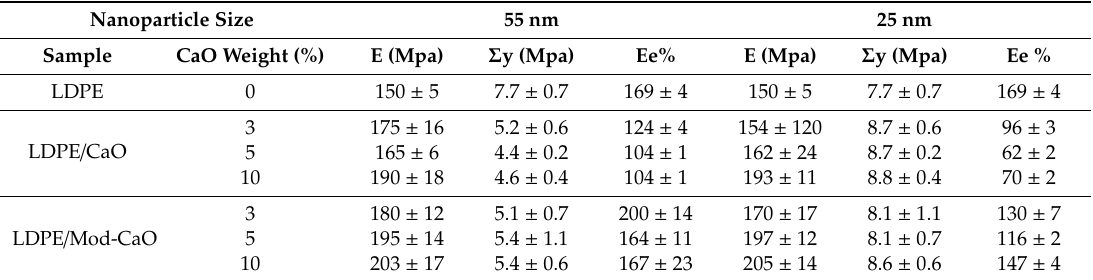
Table 2. Mechanical properties of CaO / LDPE nanocomposites using nanoparticles of ca. 55 nm and 25 nm diameter.